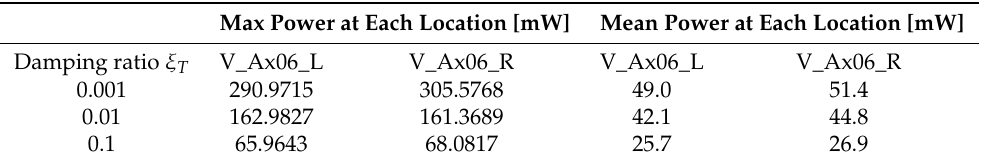
Figure 12. The relative vibration amplitudes of the harvester mass from the vertical vibration of the axles when the total damping ratio  is 0.001, 0.01, or 0.1; the mass is 0.1 kg; and the natural (cid:3021) frequency is 50.3 Hz (at the vertical direction of each left and right side of number 6 axle : V_Ax06_L and V_Ax06_R).